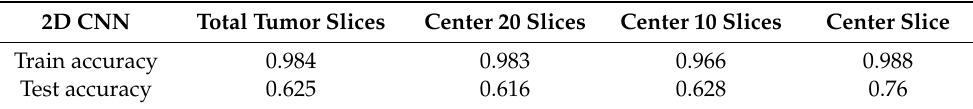
Figure 6. Deep features T-SNE plot using patients of osteosarcoma baseline PET0. In the plot, 0 represents the chemotherapy non-responder and 1 represents the chemotherapy responder. The accuracy of test set for neoadjuvant chemotherapy response prediction deep learning